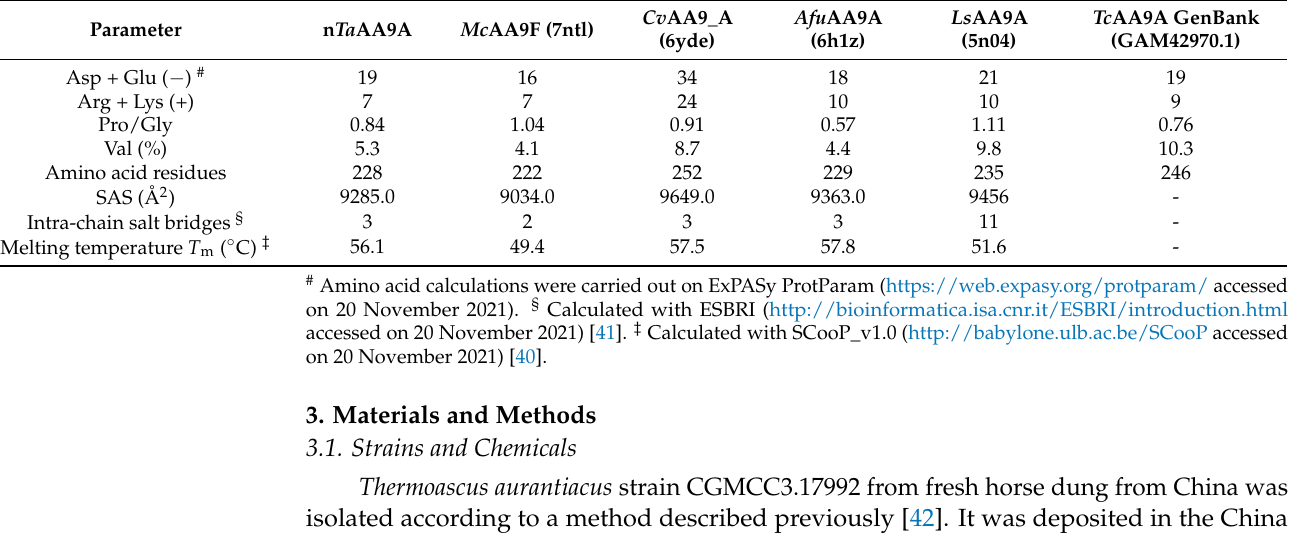
Table 2. Comparative statistics of thermostability parameters in AA9 LPMOs #